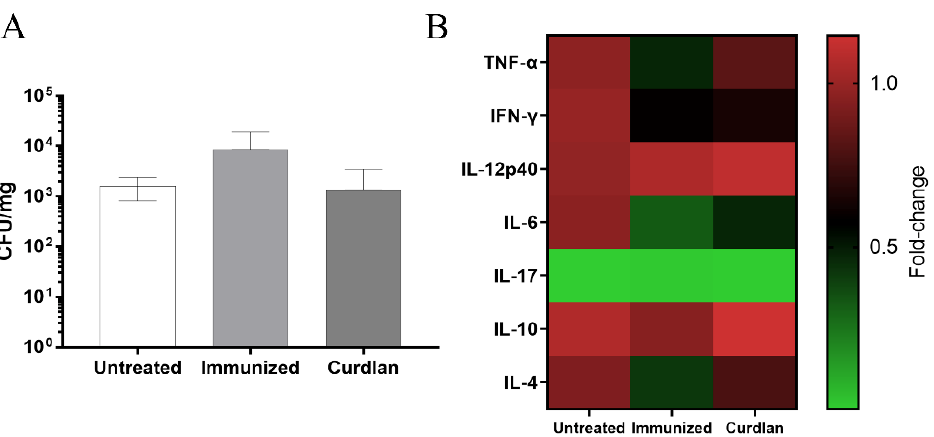
Figure 4. Measurement of the pulmonary fungal burden and cytokine levels in the lungs of immunized BALB/c mice after C. gattii challenge. After administering curdlan or PBS, the mice were immunized with HK- C. gattii -thin. On day 45 (14 d.p.i.), the mice were challenged with C. gattii . On day 59 (14 d.p.i.), the lungs of the mice were harvested and homogenized. The supernatants were used to ( A ) determine the colony-forming units (CFU), normalized to the lung mass (CFU/mg), and ( B ) measure the levels of cytokines tumor necrosis factor- α (TNF- α ), interferon- γ (IFN- γ ), interleukin (IL)-12p40, IL-6, IL-17, IL-10, and IL-4 using enzyme-linked immunosorbent assay (ELISA). Values are expressed as mean ± SD or as medians with maximum and minimum values.